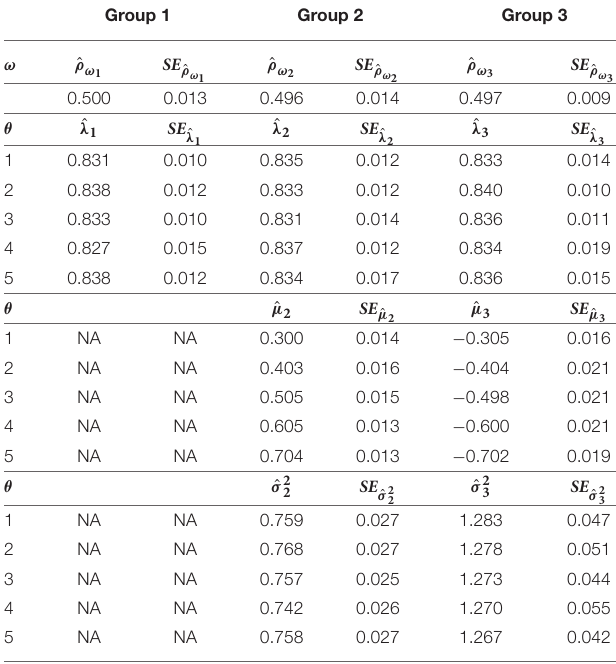
(Pearson’s r ≥ 0.985). Similarly, Figure 4 shows the scatter plots of the true and estimated second-order latent trait scores for